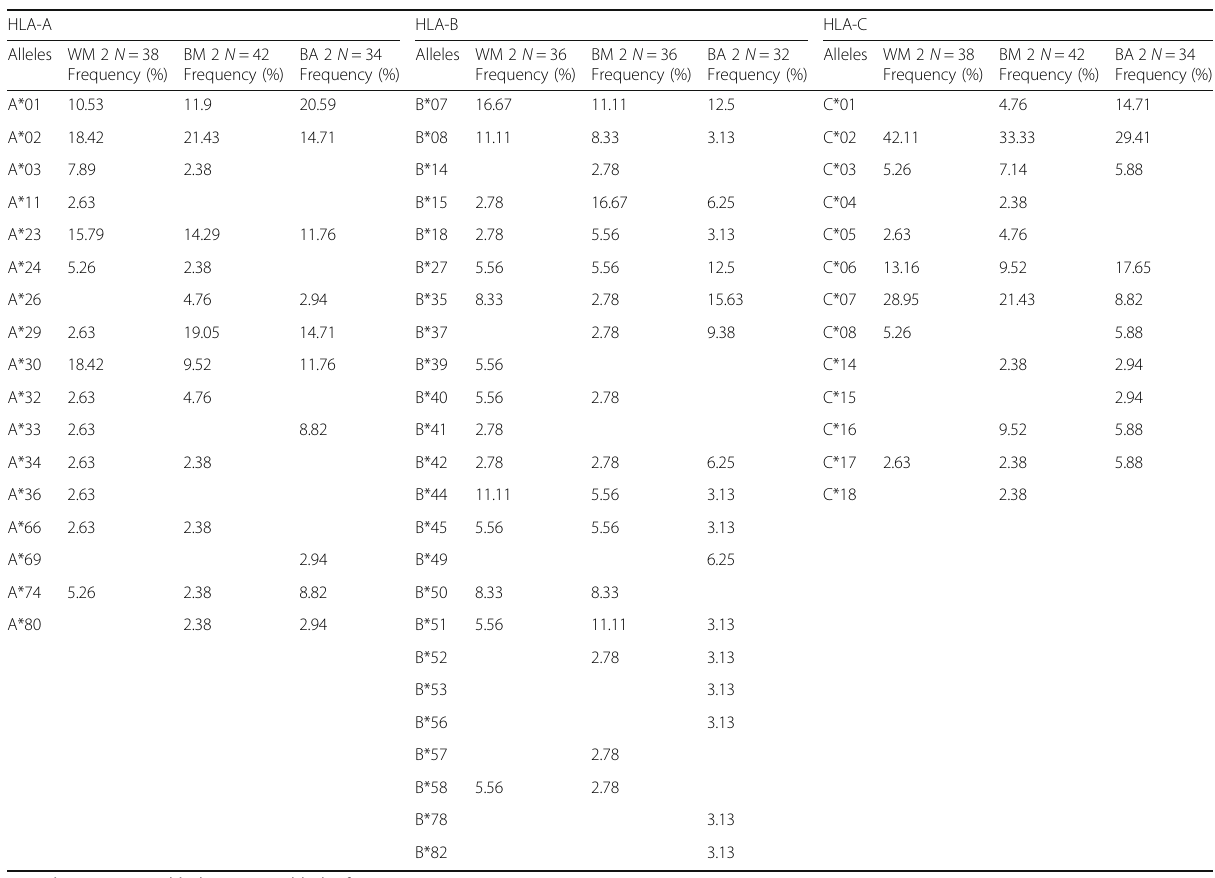
Table 2 Ethnic distribution of class I HLA HLA-A HLA-B HLA-C